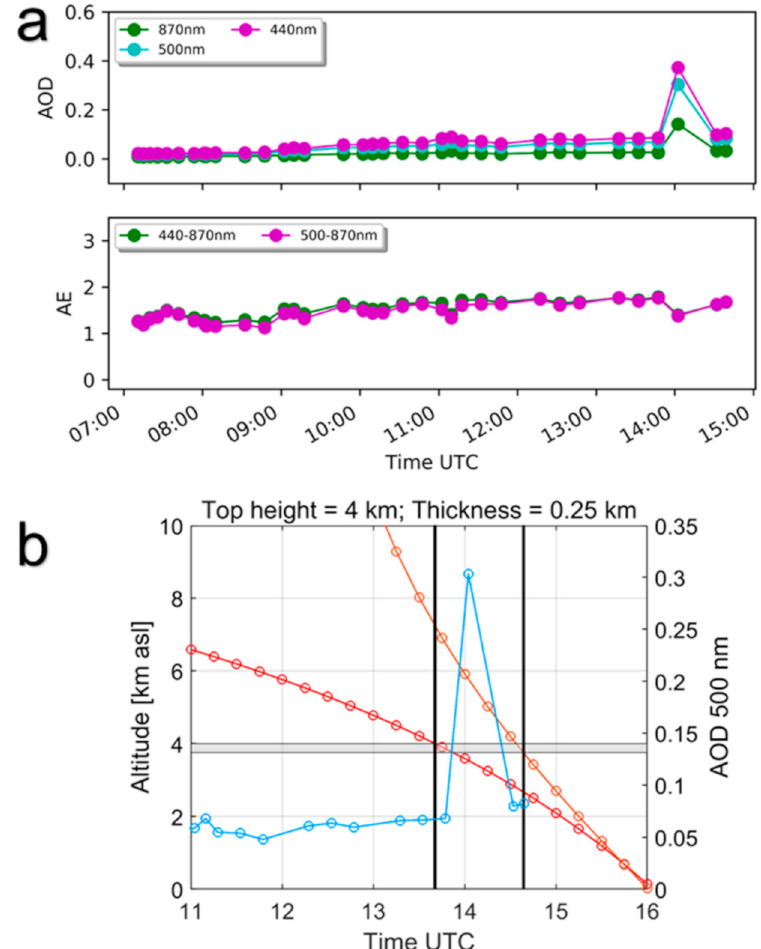
Figure 6. ( a ) The aerosol optical depth (AOD) and Ångström exponent (AE) from the sunphotometer located at the VENA station of the AERONET network (https: // aeronet.gsfc.nasa.gov / ); ( b ) time interval (between black vertical lines) in which the direction of view of sun photometer (red and brown lines) has intercepted the edges of the volcanic plume. The horizontal gray bar represents the volcanic plume, while the light blue line shows the AOD measurements at 500